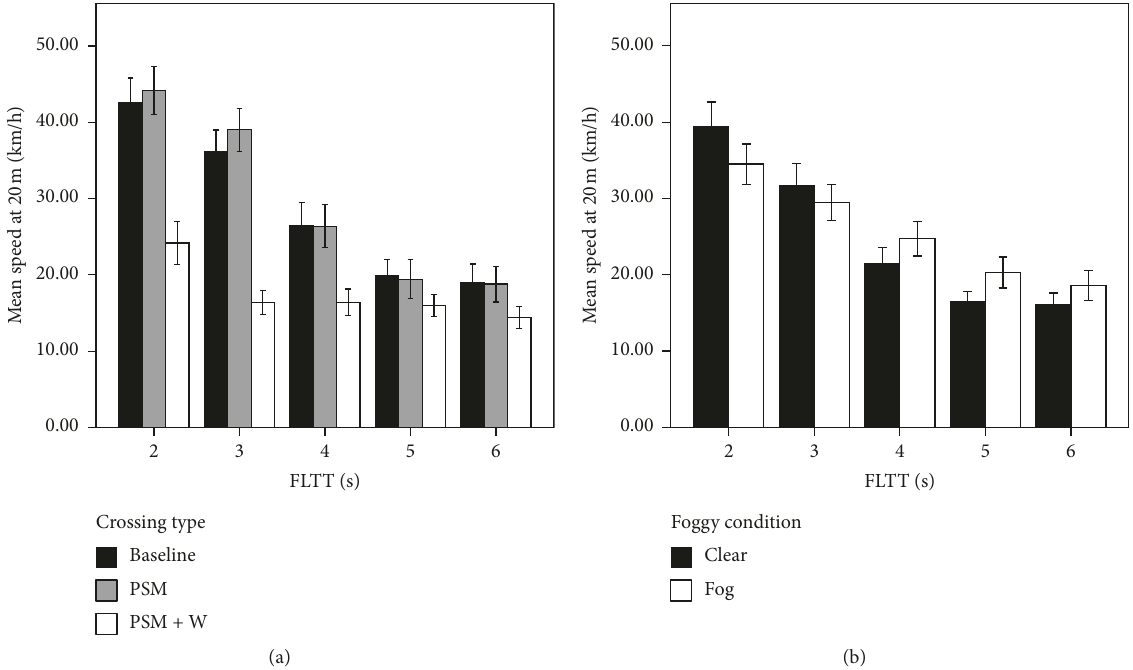
Figure 10: Mean speed at 20m to the crossing under different FLTTs. (a) The interaction effect between FLTT and crossing type; (b) the interaction effect between FLTT and foggy